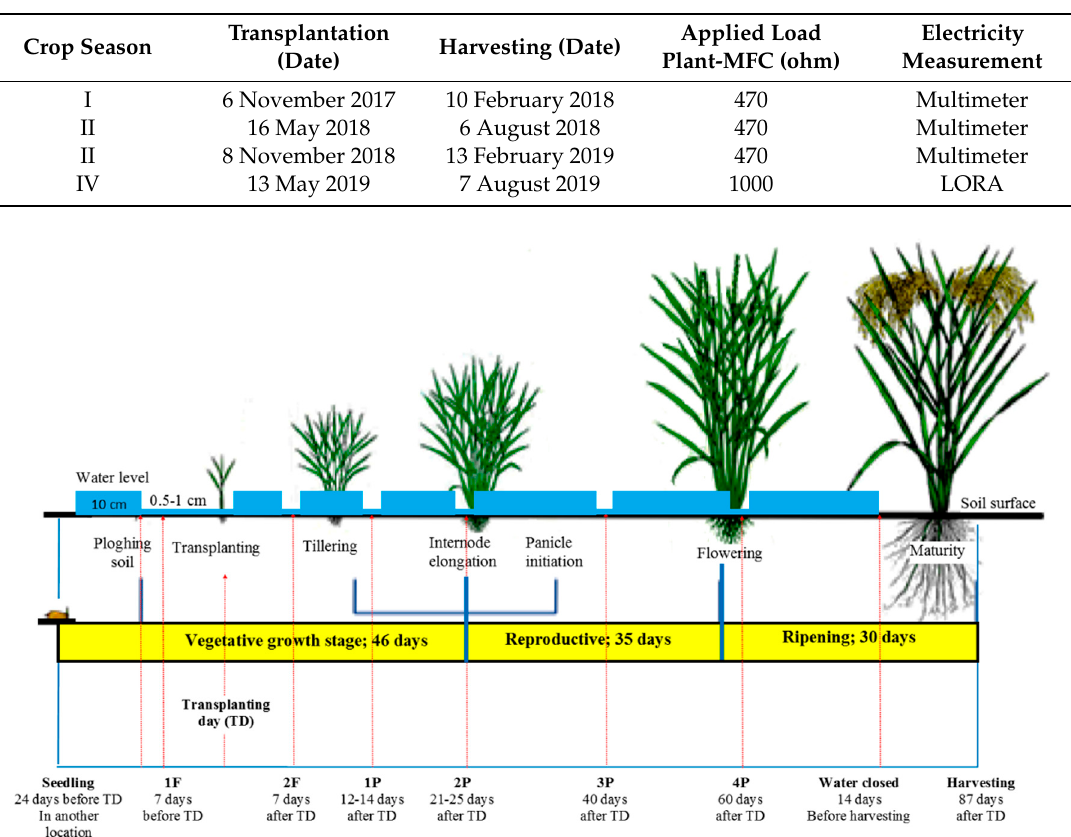
Figure 1. Growth phases of a rice paddy with water, fertilizer and pesticide management. Adapted from [31] under CC BY NC SA3.0 license.